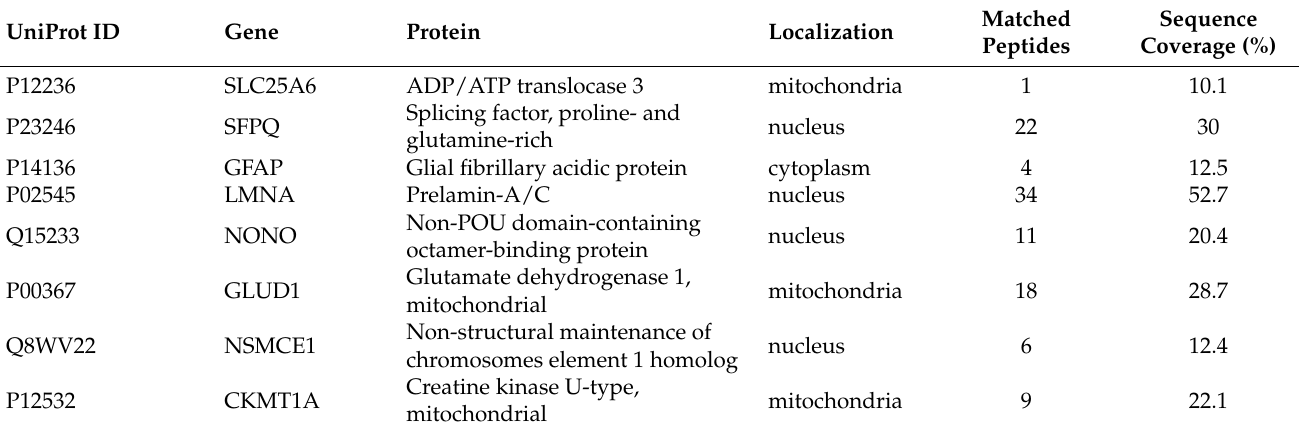
Table 5. Proteins identified in pull-down